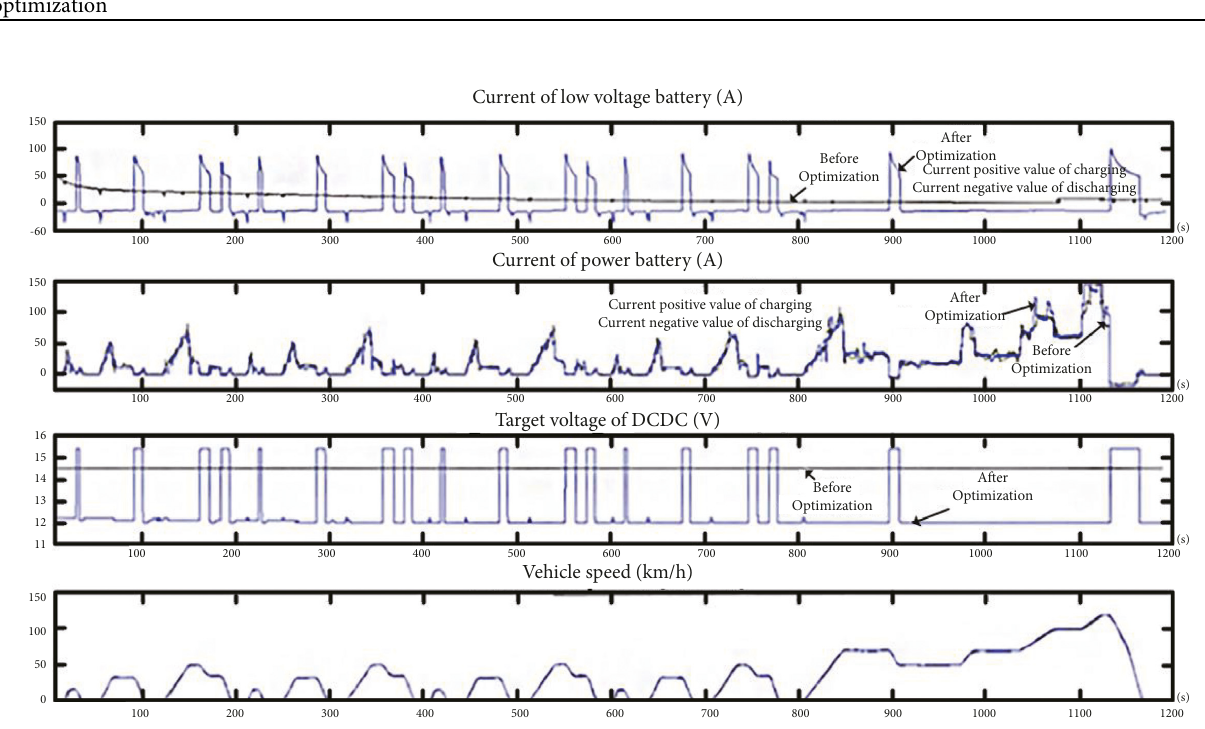
Figure 9: Comparison of two sets of tests under the first NEDC cycle. Table 4: Comparison of electric